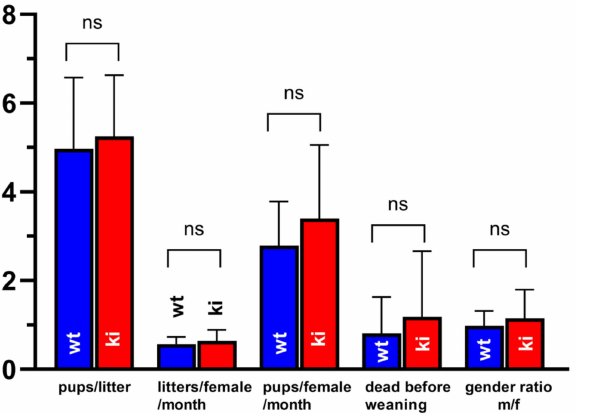
Figure 5. Comparison of fertility parameters of Alox15b -KI mice and outbred wildtype controls. For Alox15b -KI mice, 14 breeding pairs and for outcrossed wildtype controls, 18 breeding pairs (one male + 2 females) were mated and the different fertility parameters ( x -axis) were quantified over a breeding period of 56 ( Alox15b -KI mice) and 65 (wildtype controls) breeding months, respectively. ns, no significant